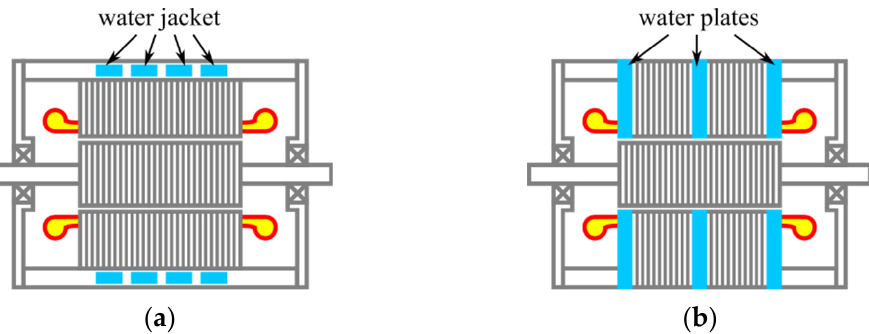
Figure 15. Water cold plate and classic water jacket solutions [98]: ( a ) water jacket; ( b ) water plates.